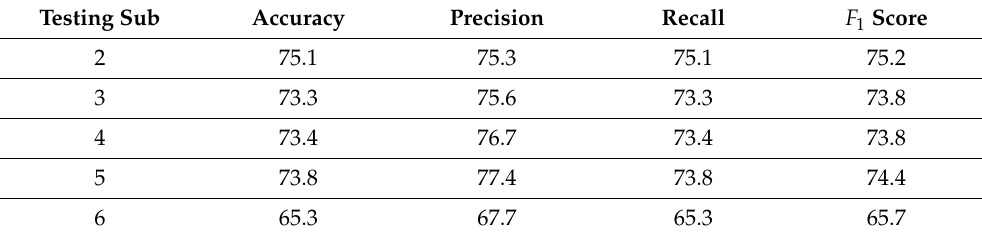
Table 3. Accuracy, precision, recall and F 1 score using 2D spectrograms of WESAD data with